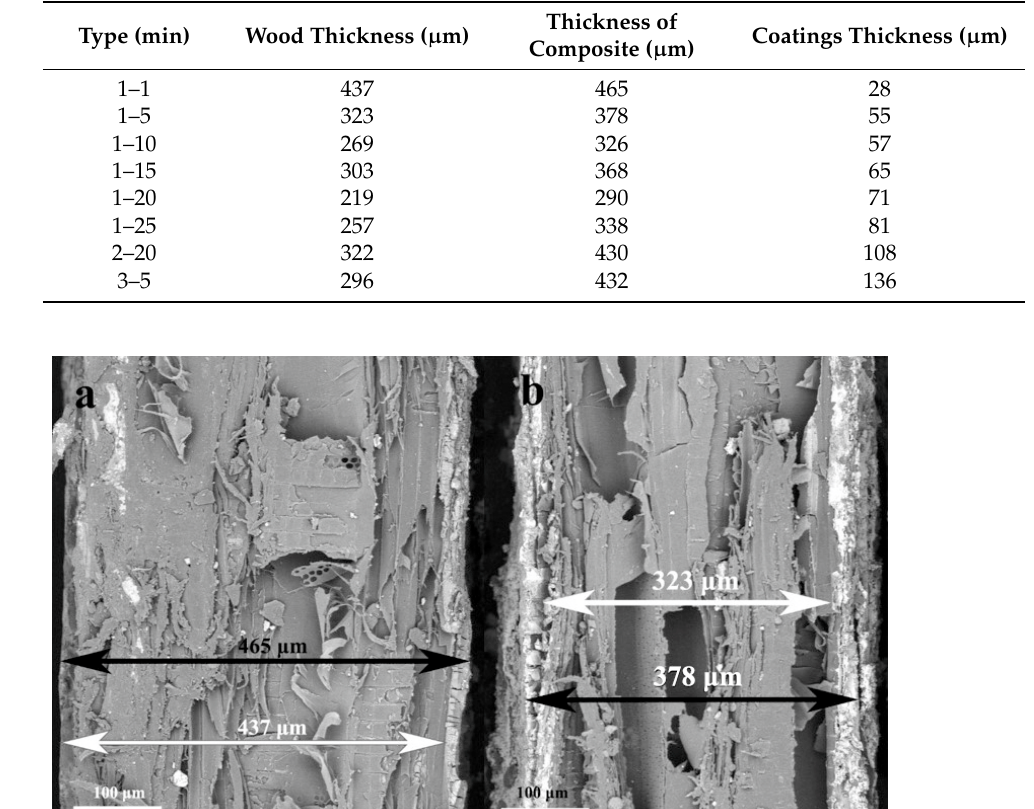
Table 2. Section thickness of wood-based composites.